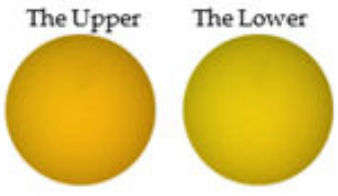
Figure 18. Experimental picture of Sample 2. Table 5. Experimental data of the thickness of Sample